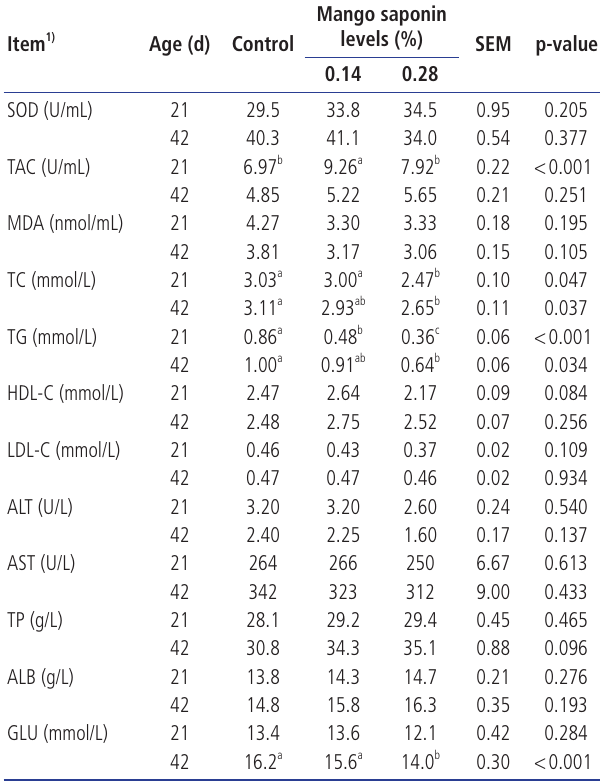
Table 5. Effect of dietary mango saponin supplementation on plasma antioxidant and biochemical indices of broiler